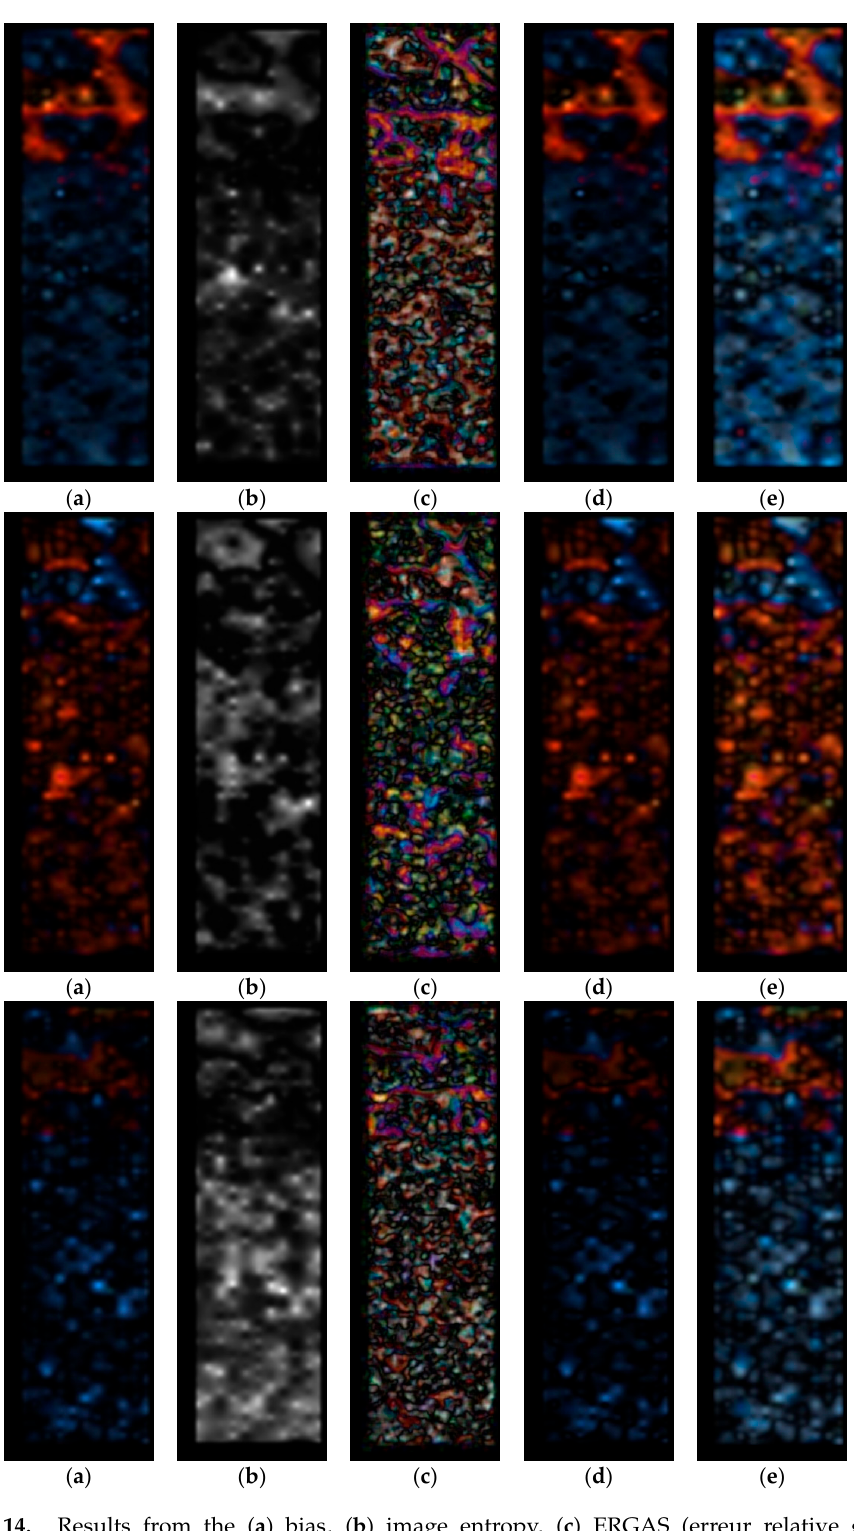
Figure 14. Results from the ( a ) bias, ( b ) image entropy, ( c ) ERGAS (erreur relative globale adimensionnelle de synthèse), ( d ) RASE (relative average spectral error), and ( e ) RMSE (root mean squared error) quality image methods. The first row refers to the first depth slice (0.00–0.20 m), the second row to the 0.20–0.40 m depth slice and the third row to the 0.40–0.60 m depth slice. Red values represent higher mismatch between the ‘real’ image (GPR) and the ‘modeled’ image (BNN model) while blue color lower values. The radiometric scale of the images was set to 8 bit